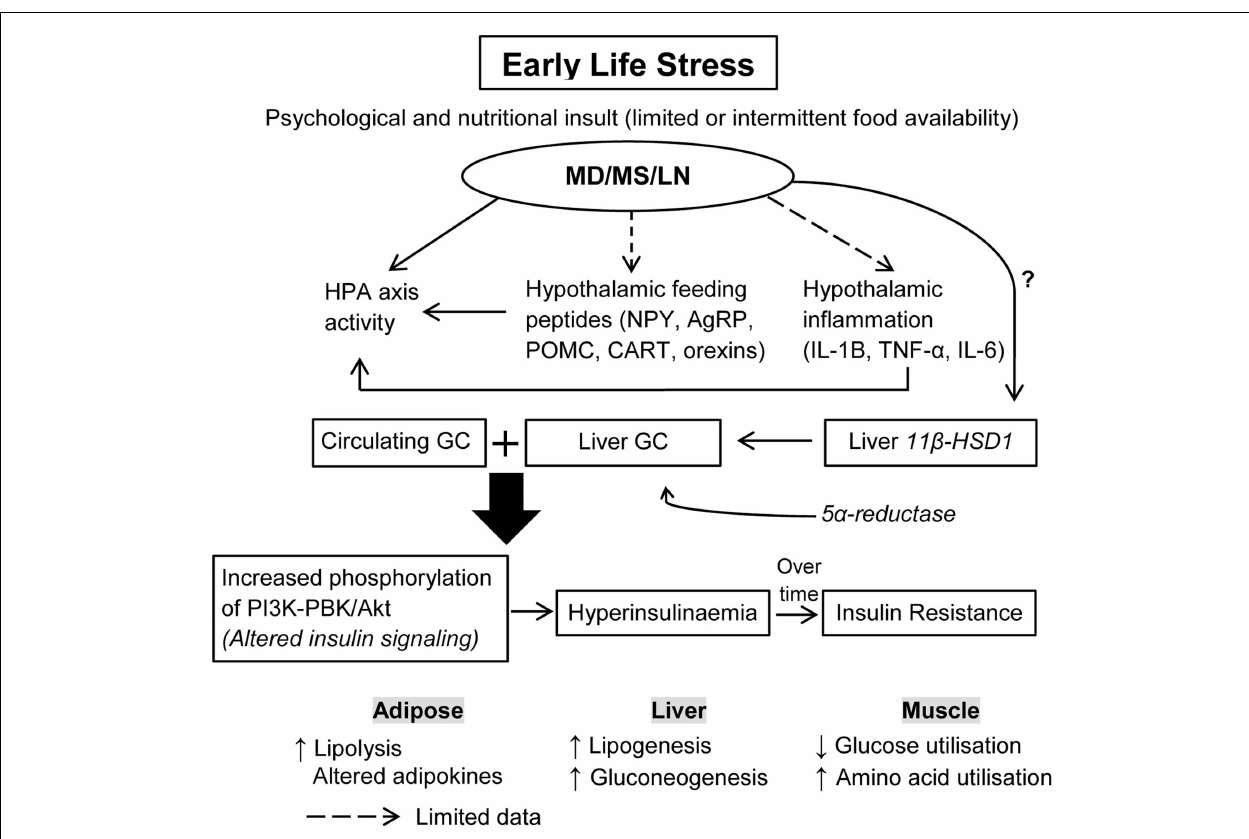
proposed that during the maladaptation period, ELS affects tissue levels of these enzymes, thus increasing exposure of peripheral tissues to GC. Excess GC availability can alter insulin signaling, leading to hyperinsulinemia and insulin resistance over time.Thus, increases in circulating and tissue GC induced by ELS act synergistically to exacerbate insulin resistance in peripheral tissues and alter energy expenditure and utilization. ELS, early-life stress; MD, maternal deprivation; MS, maternal separation; LN, limited nesting material; GC, glucocorticoids;TNF- α , tumor necrosis factor alpha; IL-6, interleukin 6; IL-1 β , interleukin-1 beta; 11 β -HSD1, 11-beta hydroxysteroid